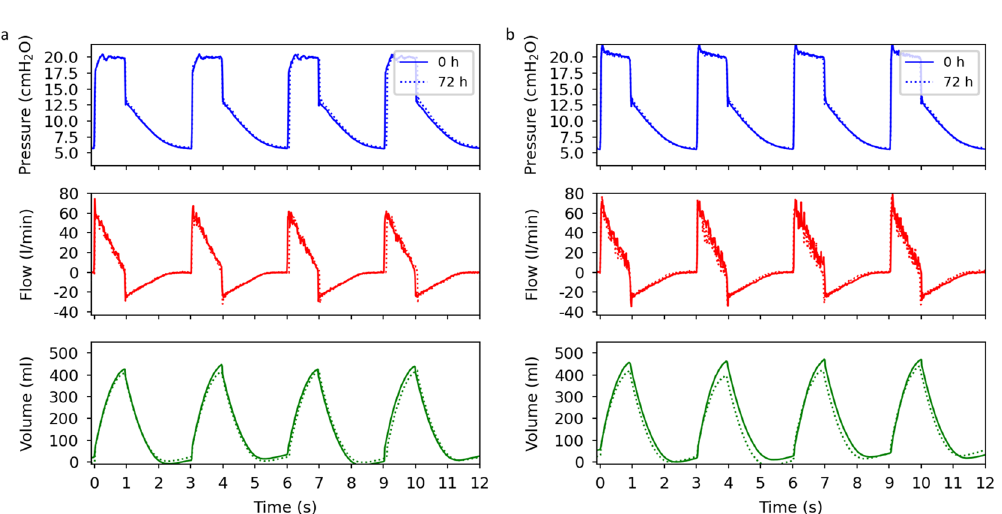
Figure 4. Plots of the airway pressure, flow, ventilation volume as a function of time for the CPAP machines ( a ) u1 and ( b ) u4 (see Table 3). The curves represent the ventilation performance after turning on the ventilator (0 h) and after running for 72 h without a break (72 h). All measurements are performed on an artificial lung. PIP: 20 cmH2O, Respiratory rate: 20 bpm, I:E ratio: